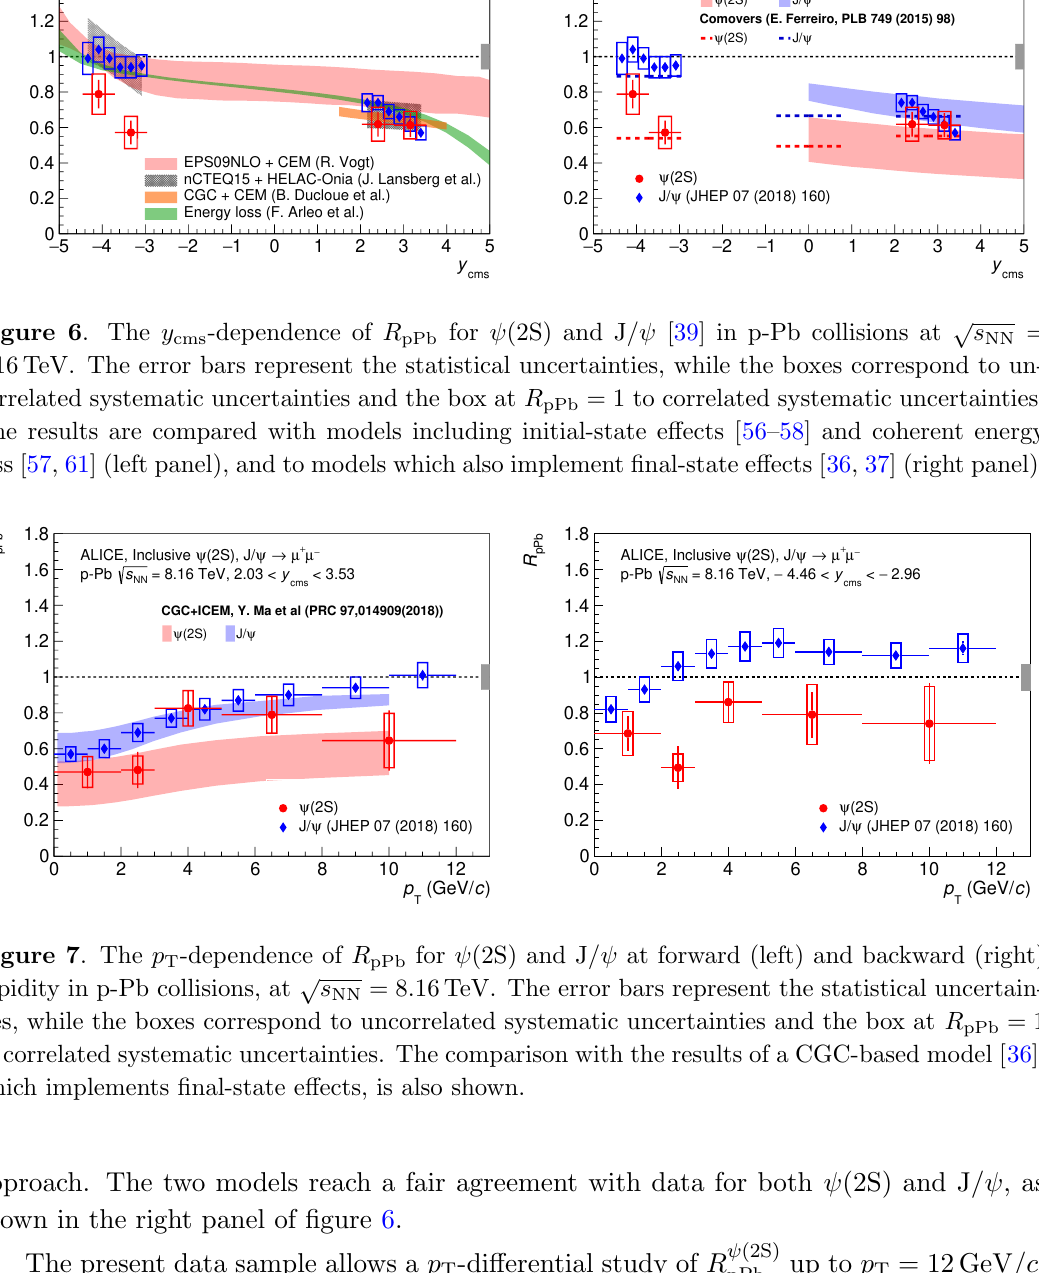
Figure 7 . The p T -dependence of R pPb for (2S) and J/ at forward (left) and backward (right) p rapidity in p-Pb collisions, at s NN = 8 : 16 TeV. The error bars represent the statistical uncertain- ties, while the boxes correspond to uncorrelated systematic uncertainties and the box at R pPb = 1 to correlated systematic uncertainties. The comparison with the results of a CGC-based model [36], which implements (cid:12)nal-state e(cid:11)ects, is also